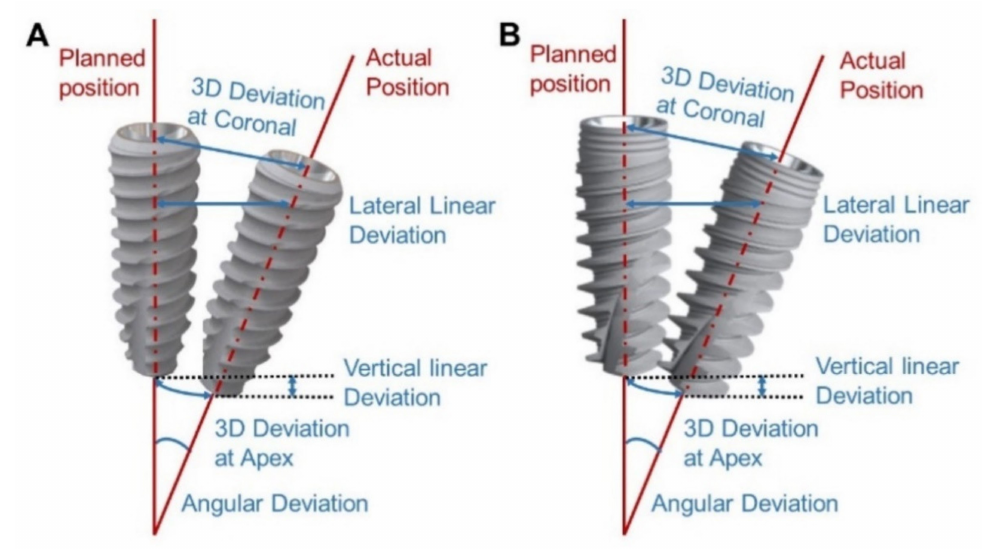
Figure 6. Deviation measurements and deviation parameters. ( A ). Dentium superline and ( B ). No- bel